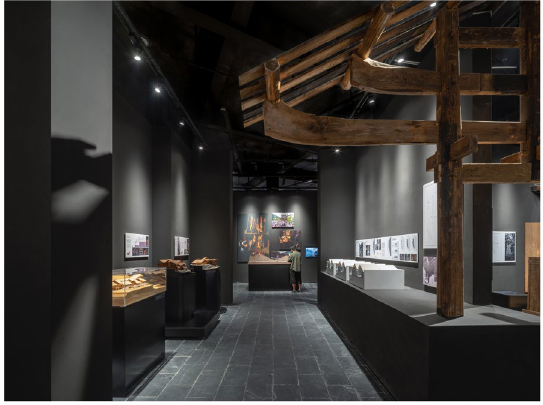
Fig. 1 The Wuling Ganlan exhibition (Source: Yilong